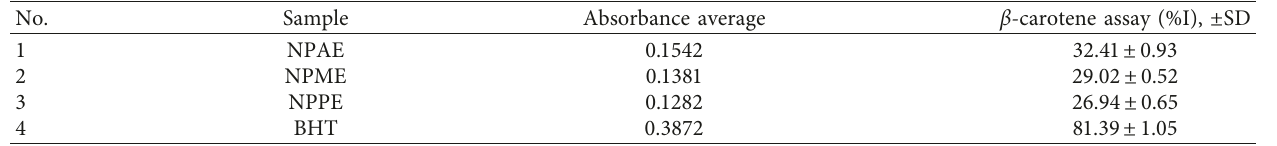
Table 4: Antioxidant activity/ β -carotene/linoleic acid bleaching assay. No.